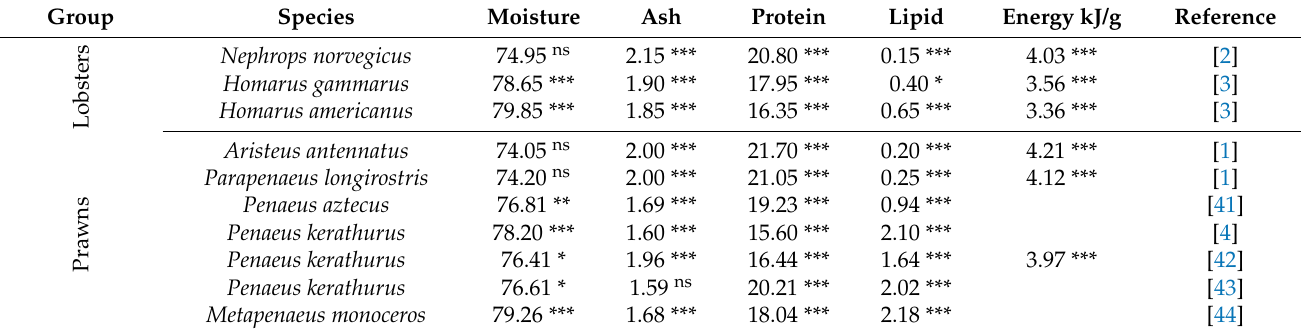
Table 3. Proximate composition (percentage of wet weight) of decapod crustacean species in the Mediterranean, or imported live, and statistical comparison with values estimated for northern brown shrimp ( Penaeus aztecus ). Data are mean values. Significance level (ns: non-significant, *: p < 0.05, **: p < 0.01, ***: p < 0.001). Group